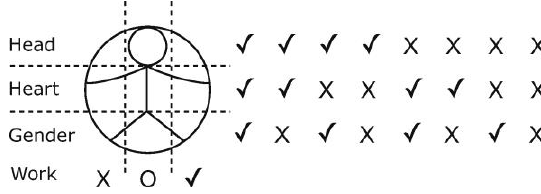
Figure 1: The Discount of Person Matrix. intelligence, thinking and useful information and discussions from the person you are talking to. The X mark indicates the negative assumption that these are missing and the person is incomplete. These √s and Xs can also apply to one’s evaluations of oneself and the world. HEART √ or X. (for feelings - kindness and warmth), Discount of Heart. The check marks √ represent the automatic positive assumption of passion, sensitivity, caring, praise, reassurance and forgiveness in your experience with the person you are talking to. The X mark indicates the negative assumption that these are missing and the person is incomplete. These √s and Xs can also apply to one’s evaluations of oneself and the world. GENDER √ or X (for sexuality - gender, attractiveness), Discount of Sex and Gender . The check marks √ represent the positive assumption of the welcome and beneficial differences of gender in others including the best of masculinity and femininity, and gives the other person the benefit of doubt by relating to them socially as they expect. The X mark indicates the negative assumption that these are missing and the person is incomplete. These √s and Xs can also apply to one’s evaluations of oneself and the world. WORK √ or X (for work - skill and willingness to work). Discount of